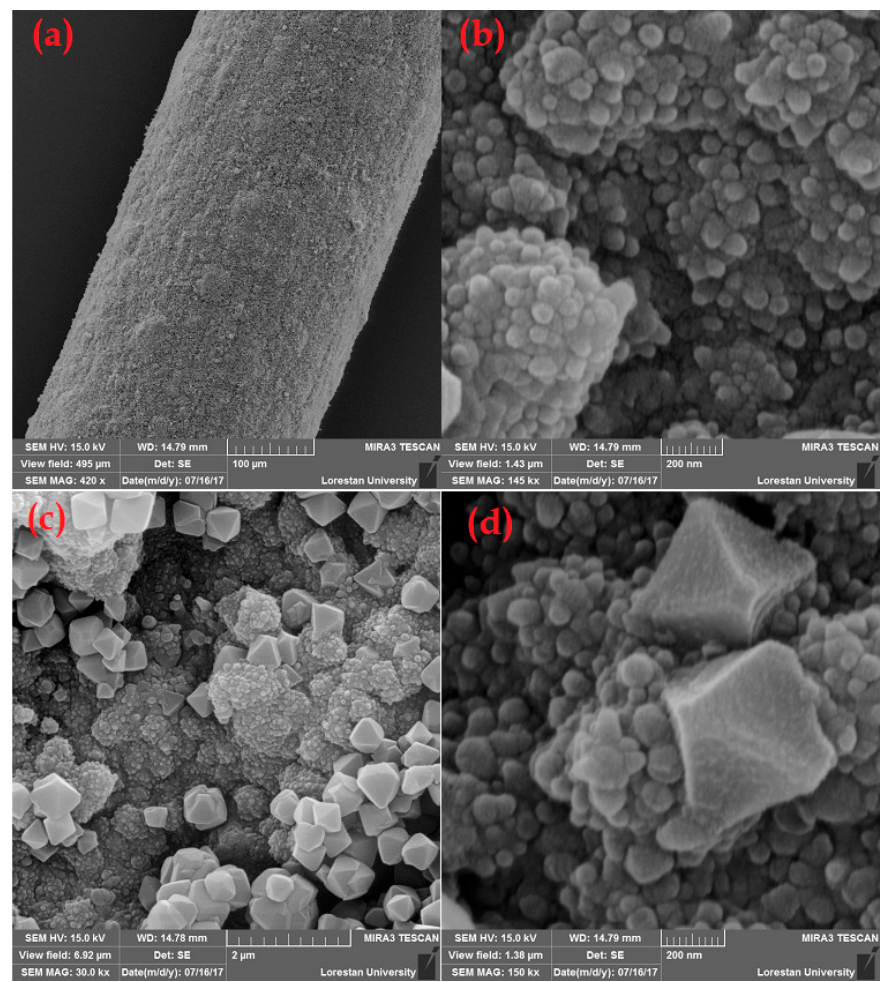
Figure 2. SEM images of the PPy@MIL-101(Cr) nanocomposite at different magnifications; ( a )100 µm, ( b , d ) 200 nm, and ( c ) 2 µm. ( b , d ) 200 nm, and ( c ) 2 µ